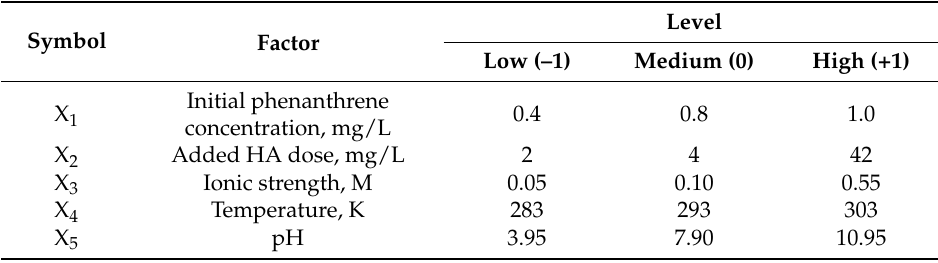
Table 1. The 3 5 experimental design of phenanthrene immobilization at the aqueous/modified palygorskite